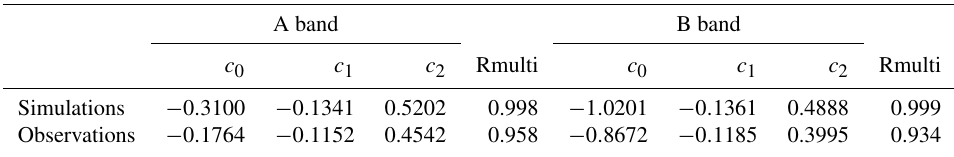
Table 2. Regression coefficients for Eq. (9) and multiple correlation coefficients (Rmulti) derived from model-simulated data and observa- tions,